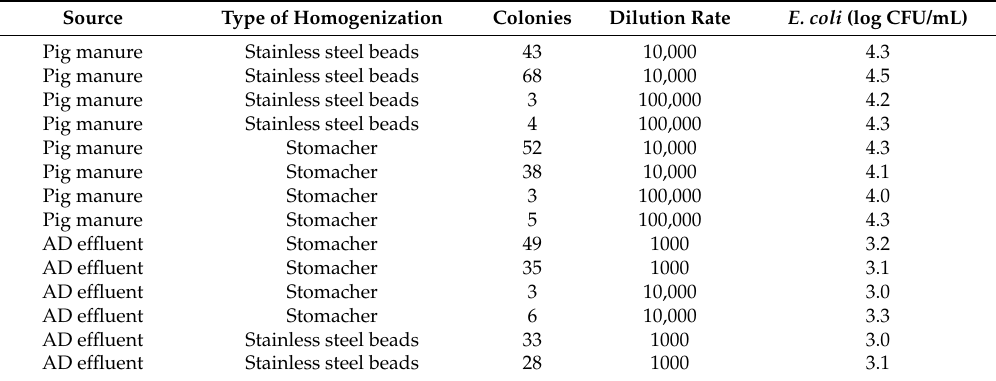
Table A1. Raw data from bacteriological homogenization